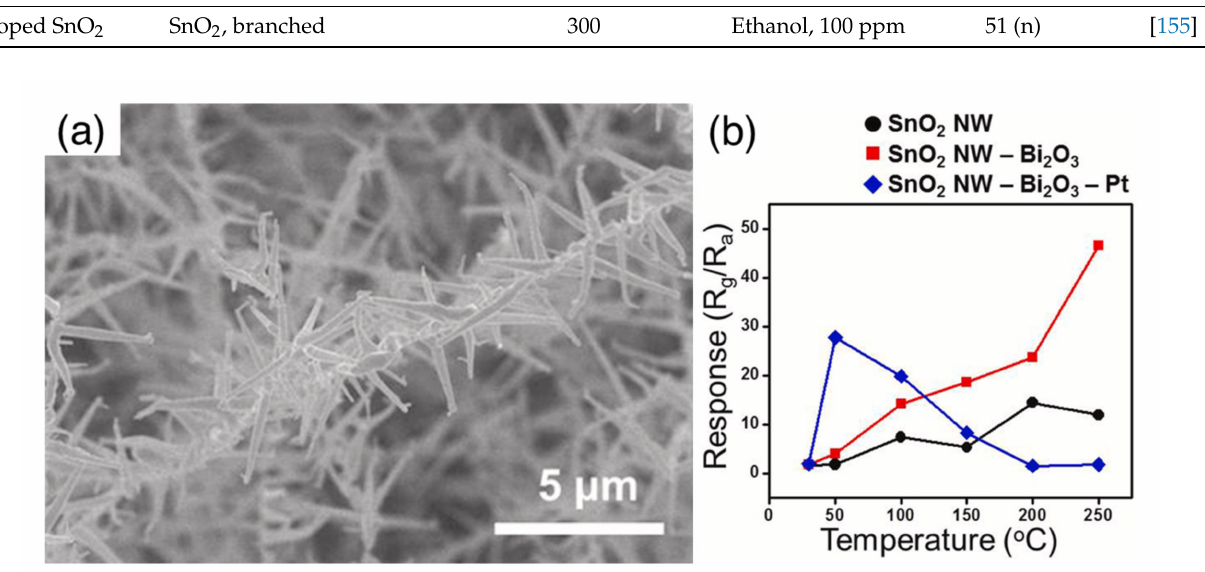
Figure 8. Branched hierarchical nanowires. SEM image of branched Bi 2 O 3 nanowires grown